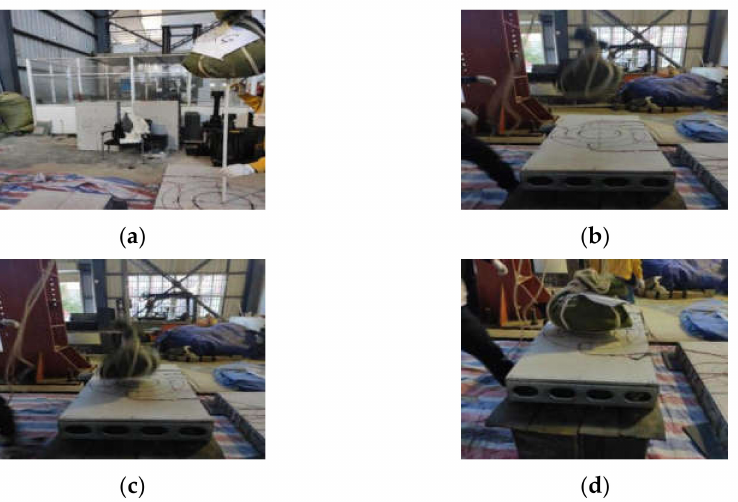
Figure 8. Test process diagram of W1. ( a ) Cross-center correction; ( b ) Falling process; ( c ) Moments before fall contact; ( d ) Collision